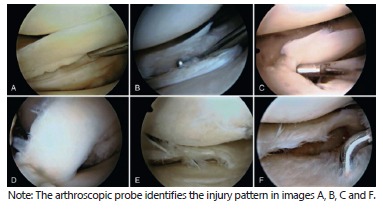
Meniscal tears classification: A) longitudinal tear; B) horizontal tear;
C) radial tear of posterior horn; D) bucket handle tear; E) complex tear; F)
degenerative lesion without tear.